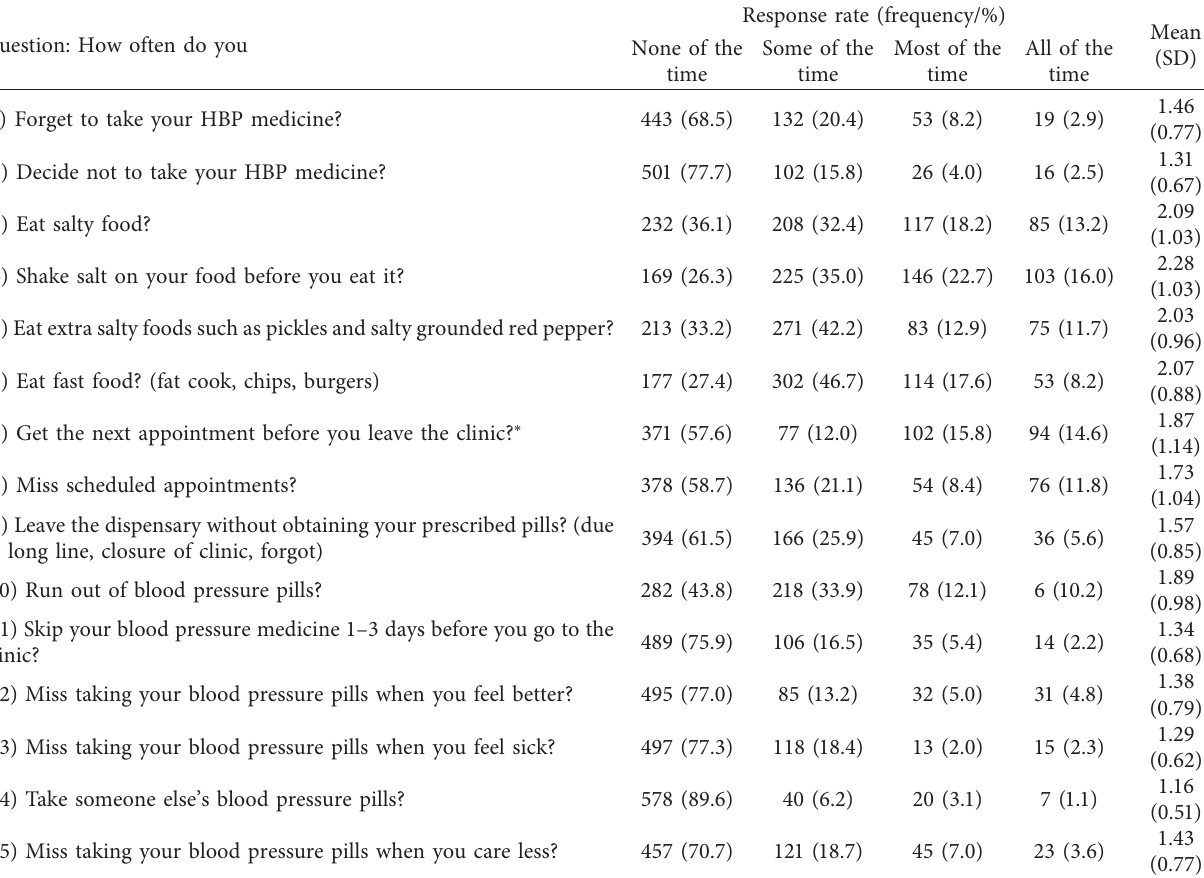
Table 4: Hill-Bone Compliance to High Blood Pressure Therapy Scale responses.